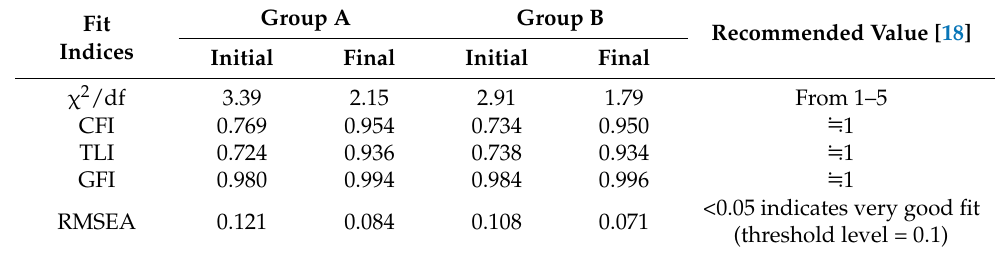
Table 3. Validity of the models for Groups A and B, and recommended goodness of fit (GoF) values.